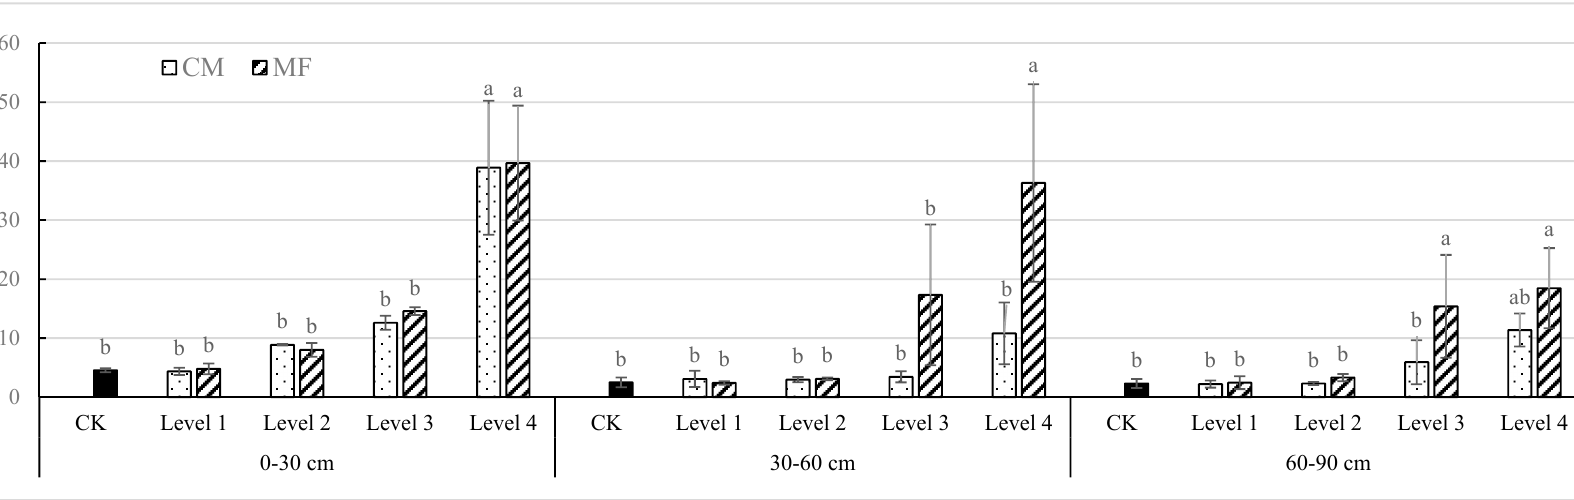
Figure 4. Soil nitrate nitrogen (NO 3- -N) content at 0–30 cm, 30–60 cm, 60–90 cm soil depth under two different types of fertilizer at four different rate levels. CK: Control treatment (non-fertilized); CM: cattle manure; MF: mineral fertilizer; Level 1 corresponding to 3 t CM ha − 1 , Level 2 to 6 t CM ha − 1 , Level 3 to 9 t CM ha − 1 , Level 4 to 12 t CM ha − 1 . Lowercase letters indicate significance groups for nitrate nitrogen contents within each level of the tested fertilizers ( p ≤ 0.05). Error bars are standard error of three replicates. Different lowercase letters indicate statistical differences ( p ≤ 0.05) among fertilizer treatments.